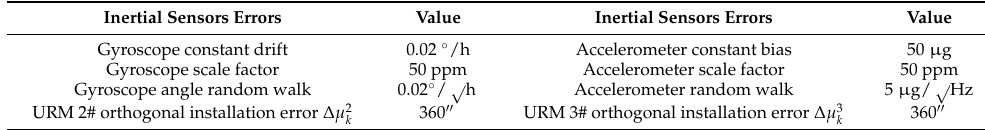
Table 2. Initial alignment errors.